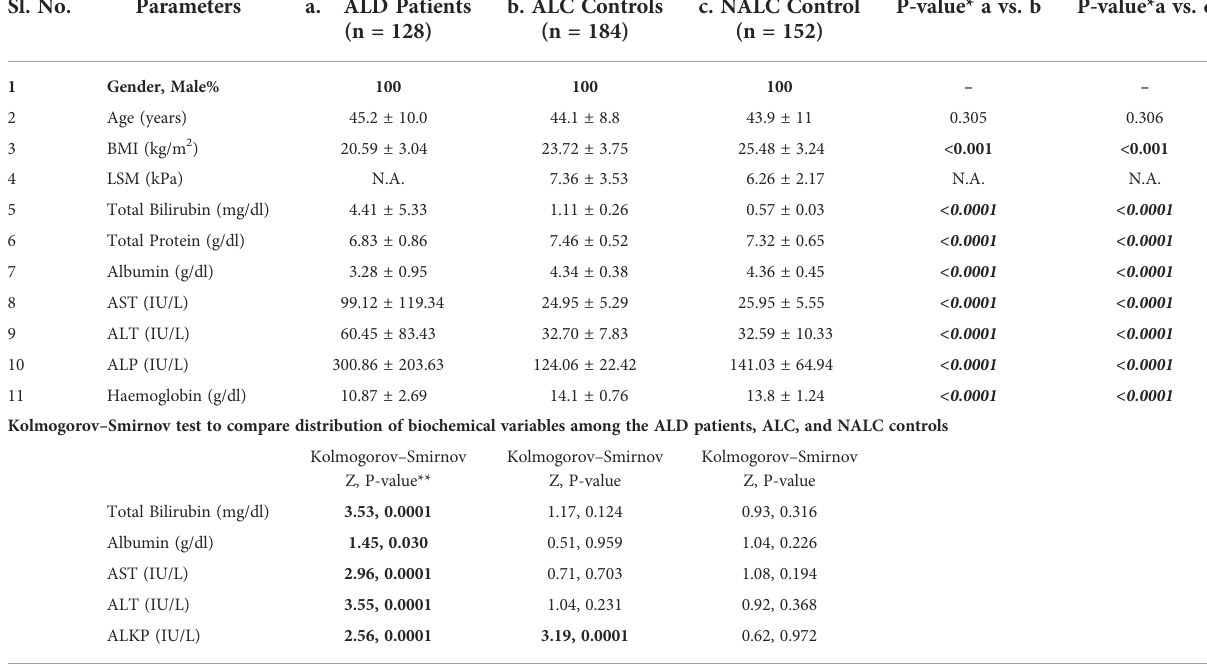
TABLE 1 Demographic, clinical and biochemical characteristics among ALD patients, Alcoholic and non-alcoholic Controls. Sl. No.